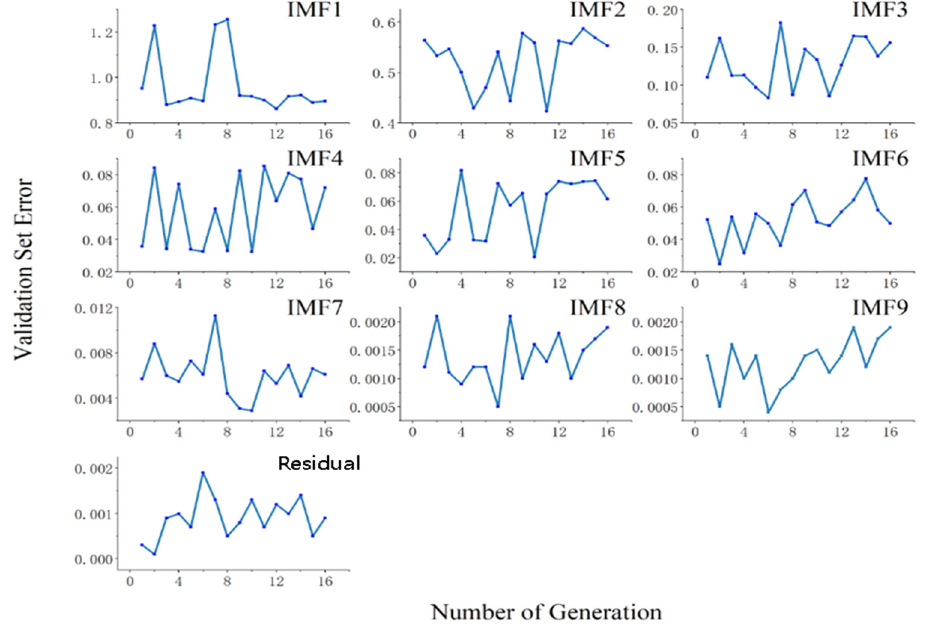
Figure 6. Propagation-loss subsequence validation set error and generated iteration (surface duct).